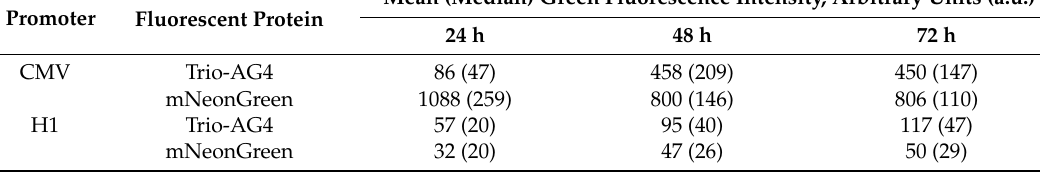
Table 1. Flow cytometry analysis of HEK293T cells transiently expressing Trio-AG4 or mNeonGreen fluorescent proteins under control of CMV or H1 gene promoters.